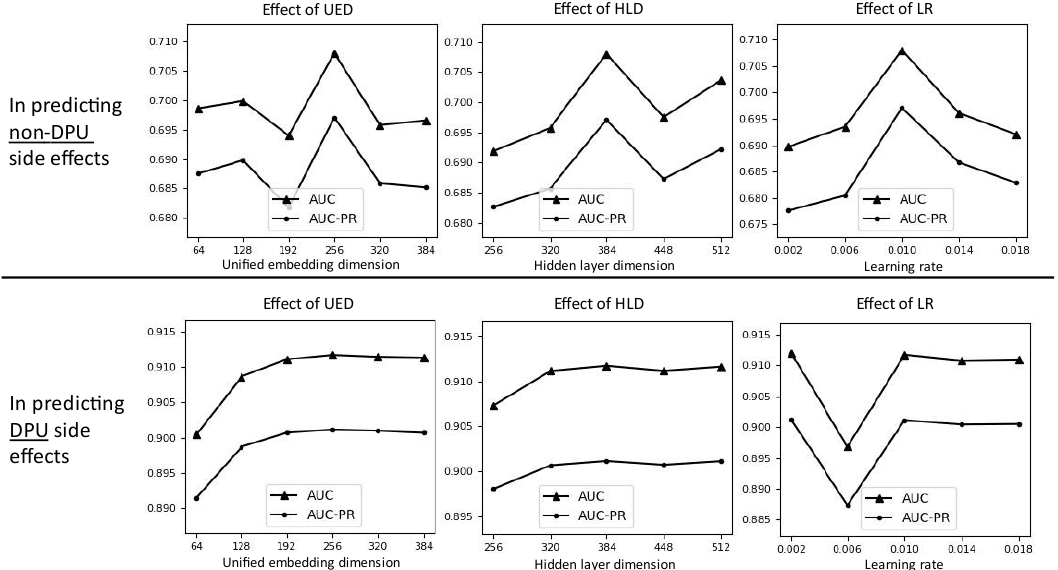
Figure 4 . Polypharmacy side effects prediction performances under different choices for each of three hyperparameters (UED, HRD, and LR).